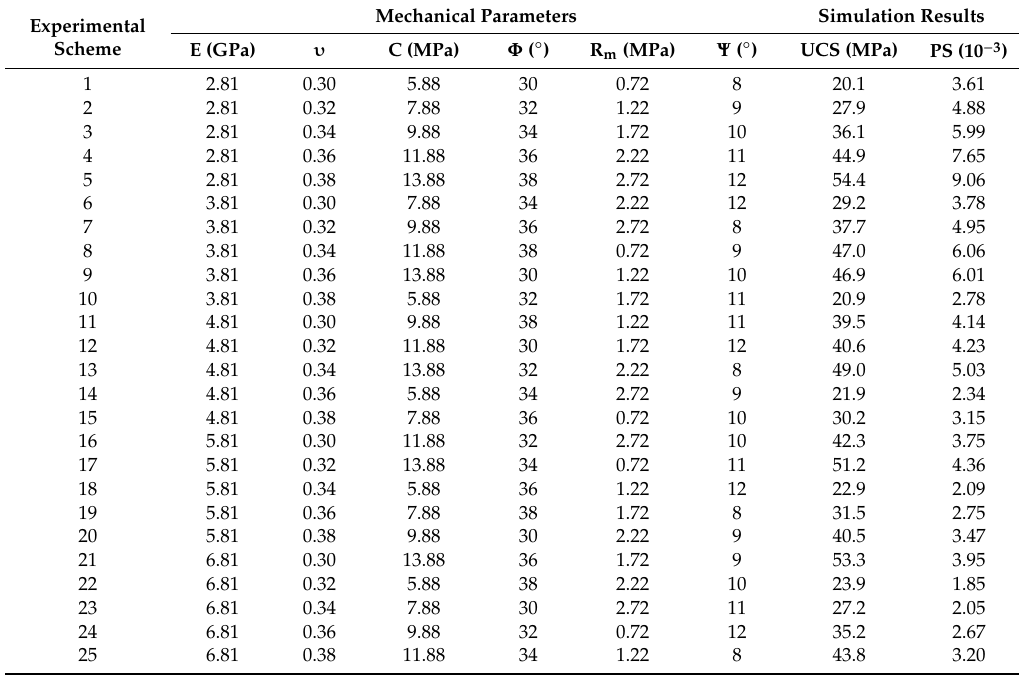
Table 4. Orthogonal numerical simulation experimental